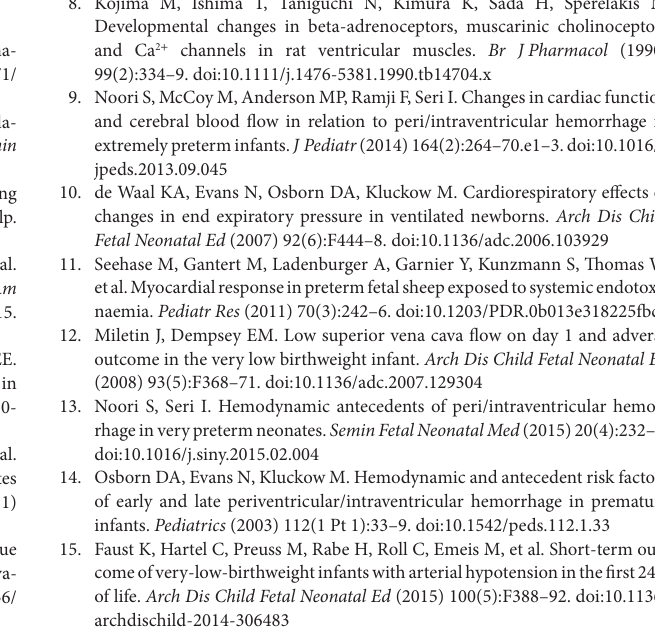
FiGURe S1 | Photo of manikin representing a hemodynamic monitoring model in an extreme preterm